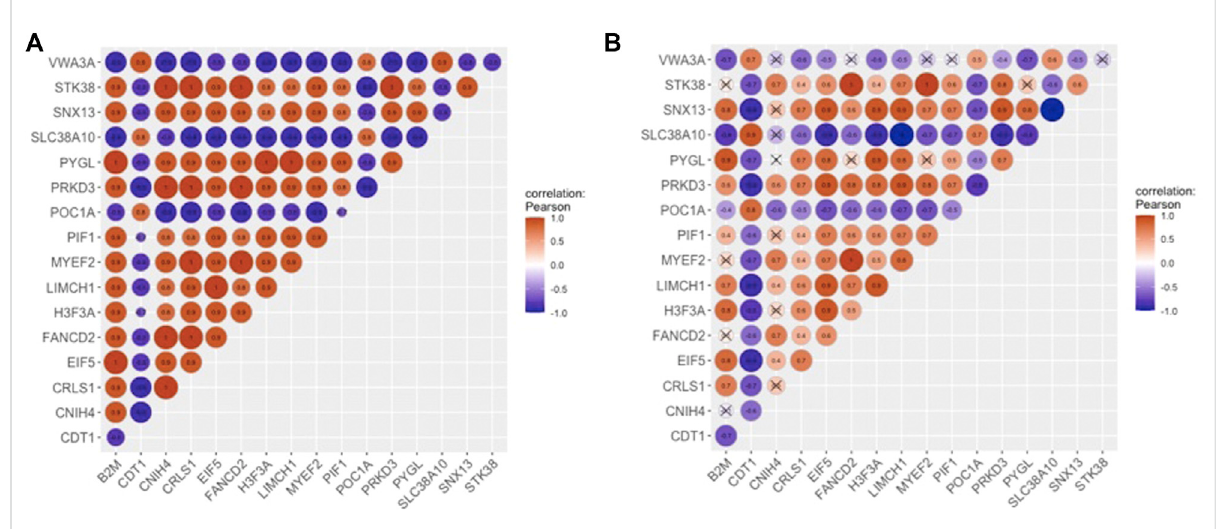
FIGURE 4 Correlations of OCM (A) in the diseased state, and (B) in healthy state. The areas of circles show the absolute values of corresponding PCC ’ s.